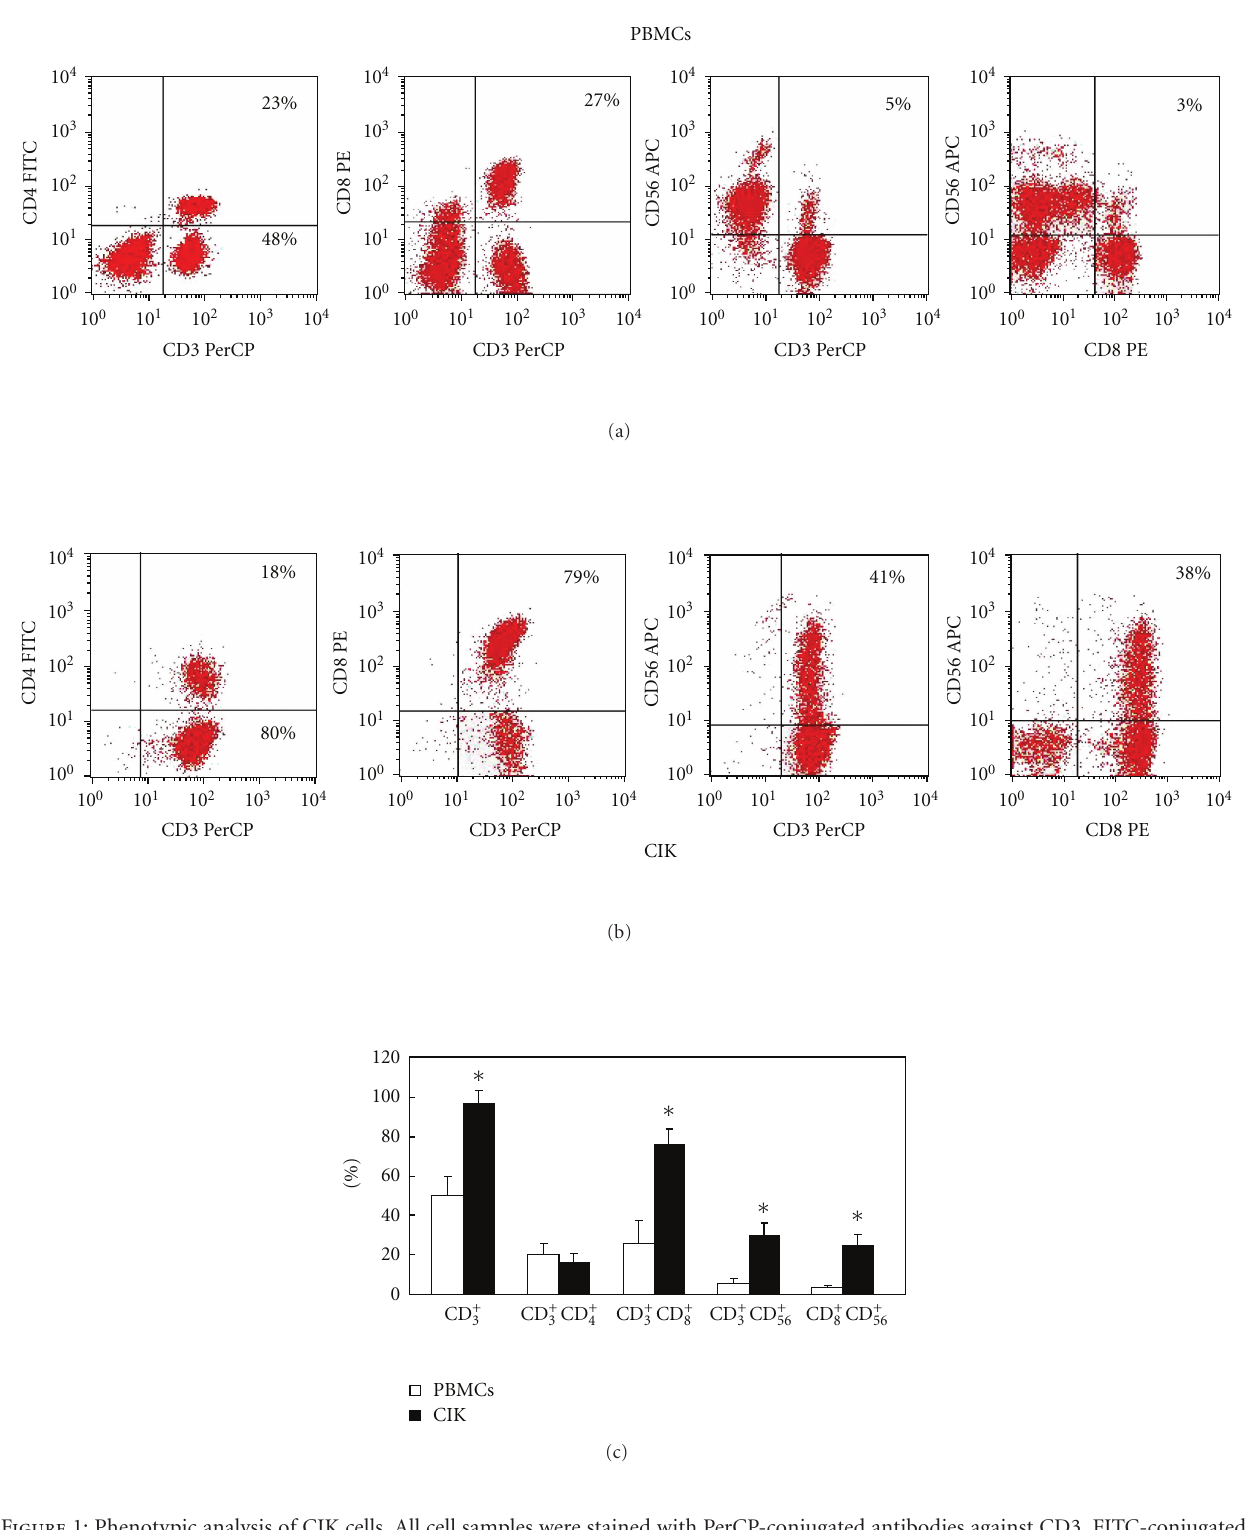
Figure 1: Phenotypic analysis of CIK cells. All cell samples were stained with PerCP-conjugated antibodies against CD3, FITC-conjugated antibodies against CD4, PE-conjugated antibodies against CD8, and APC-conjugated antibodies against CD56. (a) Typical phenotypic analysis of PBMCs. (b) Typical phenotypic analysis of CIK cells. (c) Comparison of the phenotypic analyses of PBMCs and CIK cells. The PBMCs population was composed of 50% CD3 + cells, 4% CD3 + CD56 + cells, 27% CD3 + CD8 + cells, 22% CD3 + CD4 + cells, and 3% CD8 + CD56 + cells. After culture for 14 days, the CIK cells comprised 98% CD3 + cells, 77% CD3 + CD8 + cells, 20% CD3 + CD4 + cells, 38% CD8 + CD56 + cells, and 41% CD3 + CD56 + cells. Phenotypic comparison analysis was performed from 15 samples, and the results are expressed as means ± SD. ( ∗ P < .